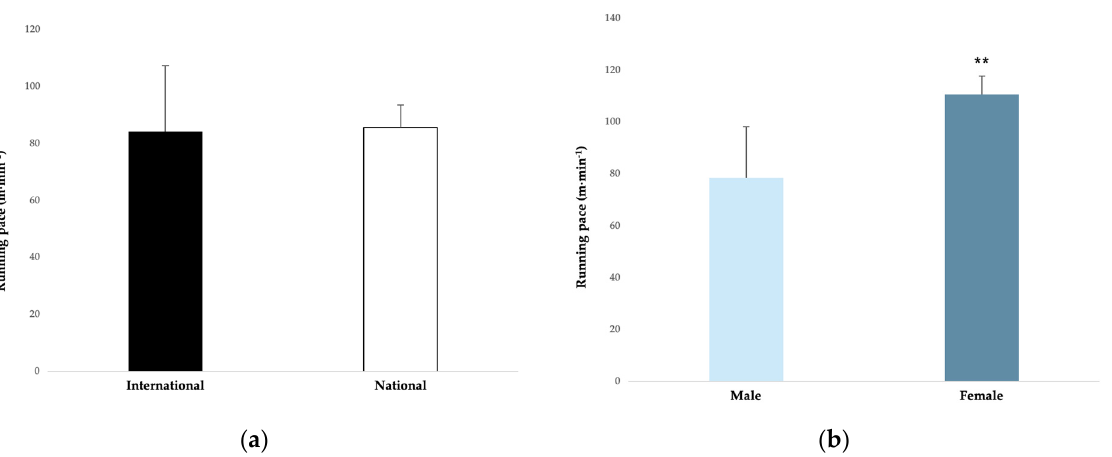
Figure 4. ( a , b ). Running pace related to the competition level and gender. The magnitude of the standardised differences (effect size) between the competition level and gender is indicated by the number of symbols: two for a large difference.